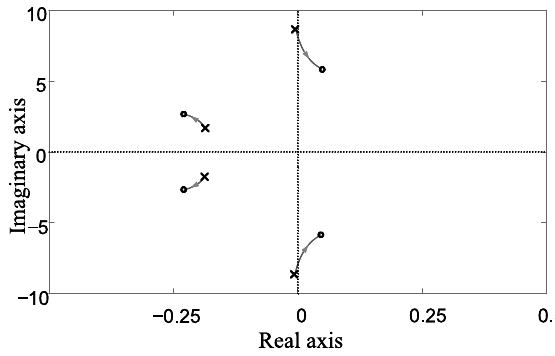
The root locus of D ( s ) when m 1 varies from 0 to +∞ is shown in Figure 10.